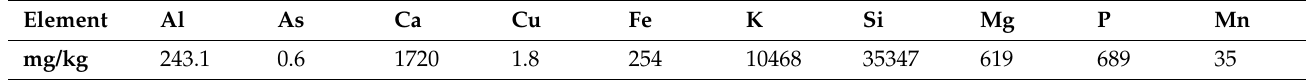
Table 2. Chemical composition of flax straw.